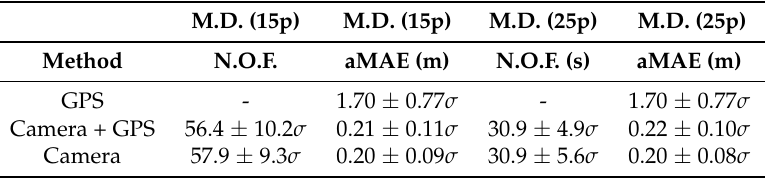
Figure 14. Estimated average of position expressed in coordinates for a minimum distance of 15 pixels: north ( left upper plot ), east ( left middle plot ), and down ( left lower plot ), and for a minimum distance of 25 pixels: north ( right upper plot ), east ( right middle plot ), and down ( right lower plot ). A period of 5 s of initialization was considered where the GPS was available. Table 1. Numerical results in real data experiments; (i) M.D. stands for minimum distance between features (in pixels units); (ii) N.O.F. stands for average number of features maintained into the system state; (iii) aMAE stands for average mean absolute error (in